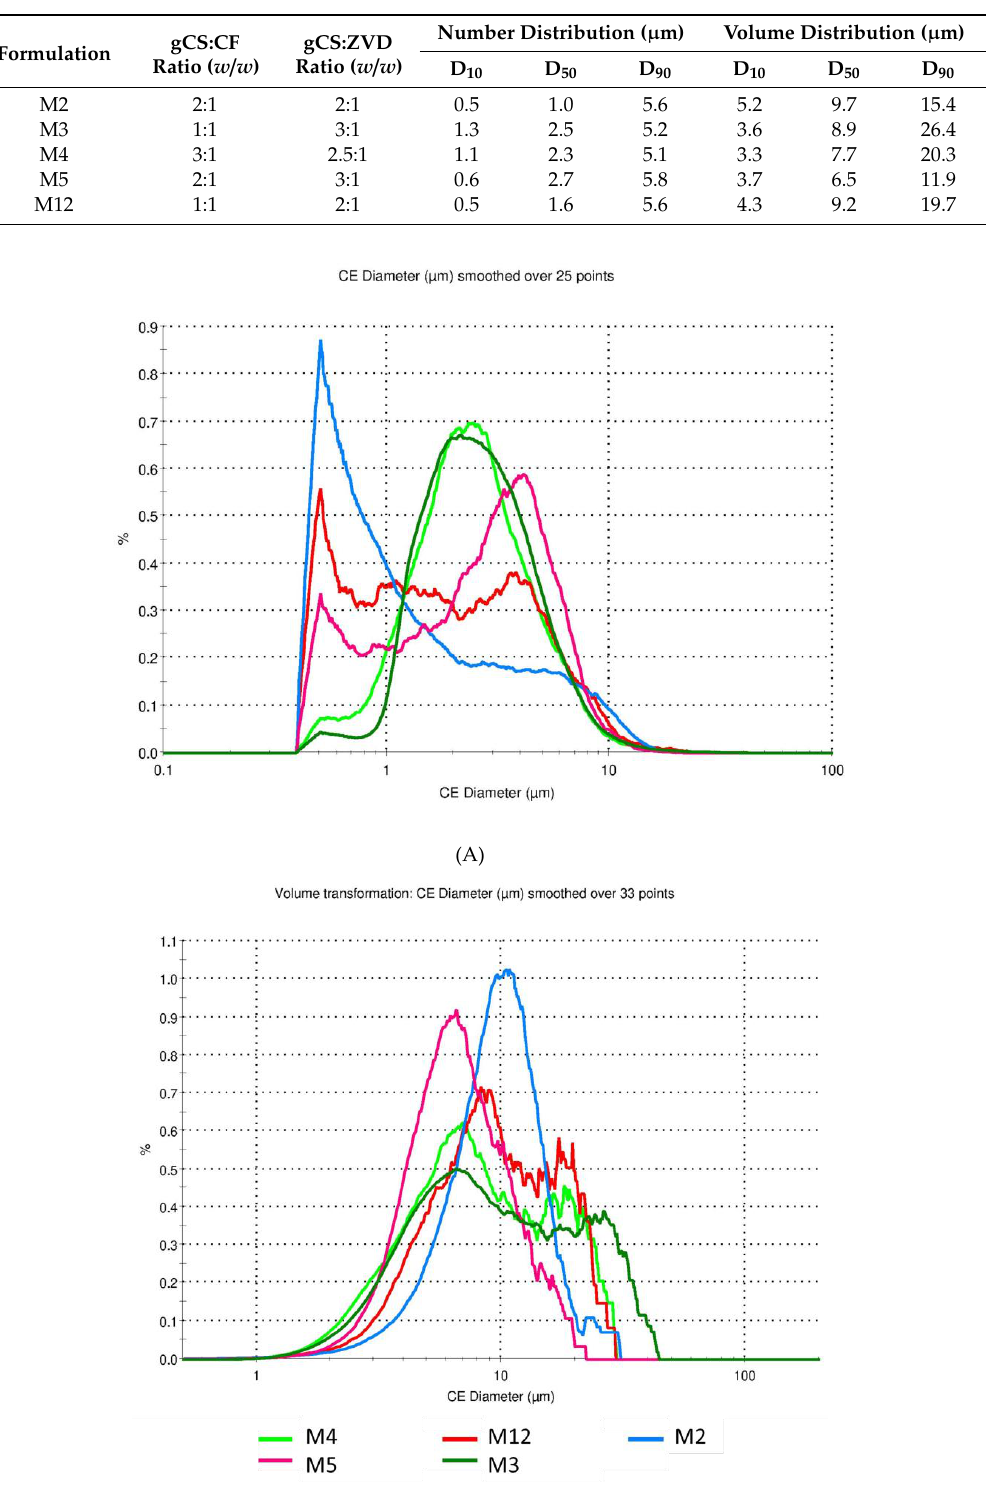
Figure 3. SEM images of zidovudine (ZVD)-loaded microparticles with chitosan glutamate and beta-glycerophosphate disodium in a ratio 3:1: M4 ( A ); 2:1: M2 ( B ) and M5 ( C ); 1:1: M3 ( D ) and M12 ( E ); original magnification ×2000.